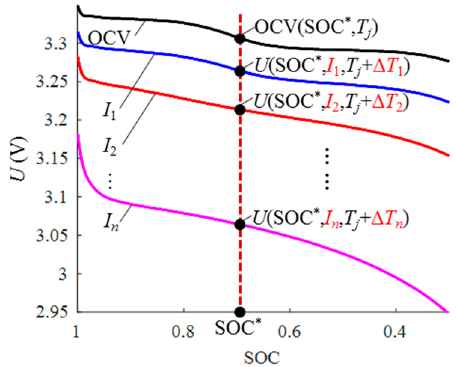
Figure 4. Test U data under the same state of charge (SOC) = SOC * , T amb = T j , but different I will result in different T bat ( Δ T stands for T bat changes during operation).